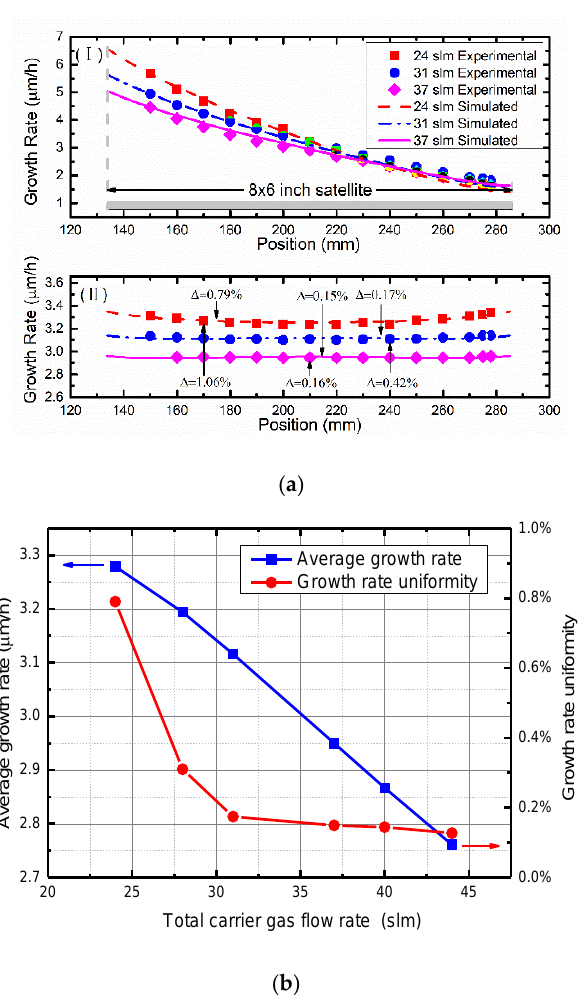
Figure 4. Simulated results of the average growth rate and growth rate uniformity as functions of the total AsH 3 flow rate. P = 5 × 10 3 Pa, T growth = 700 °C, carrier gas flow rate Q H2 = 37 slm. As the triple-flow injector technology was applied in the 8 × 6 inch planetary reactor, the ratio of the AsH 3 flow rate through the top and bottom channels could be used as a tuning parameter for the growth rate uniformity, which was realized by optimizing the depletion profile with respect to the upstream leading wafer edge position [12]. Figure 5 shows the effects of the AsH 3 ratio on the static and rotating growth rate profiles. It reveals that at higher top AsH 3 flow rates, higher growth rate values are obtained at the upstream end of the static curve, which is close to the reactor center since the higher top AsH 3 flow rate shortens the nutrient species entrance length [14]. As shown in Figure 6, higher top AsH 3 flow rate improves the concentration of TMGa near the leading wafer edge. With